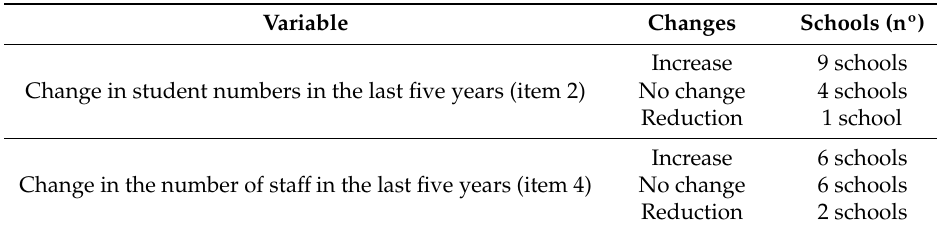
Table 2. Changes in the number of students and sta ff at schools. Variable Changes Schools (nº) Change in student numbers in the last five years (item 2)